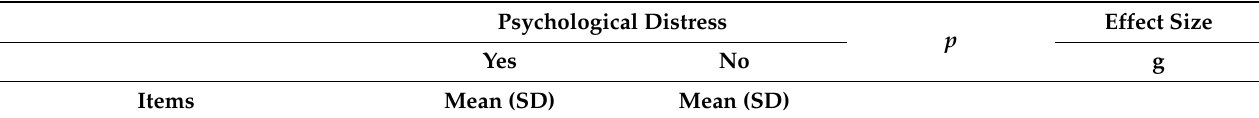
Table 5. Association between knowledge, attitudes, and practices towards COVID-19 and psycholog- ical